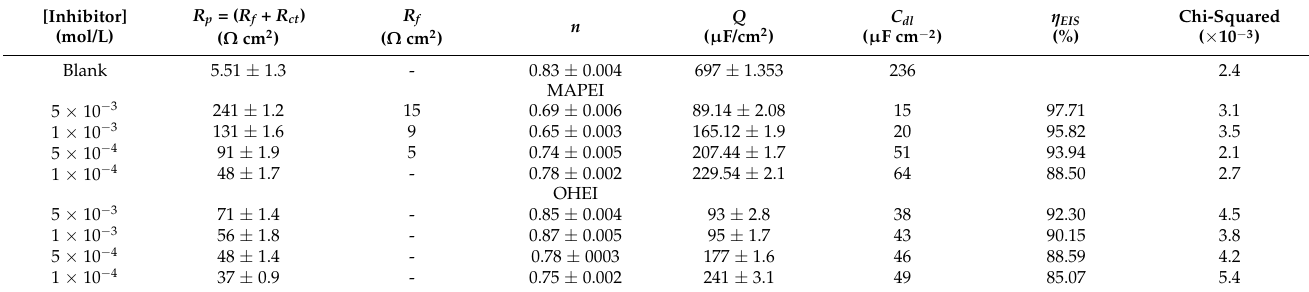
Table 2. Electrochemical parameter values estimated according to EIS curves of N80 steel in 15 wt.% HCl solution in the presence and absence of several concentrations of MAPEI and OHEI at 303